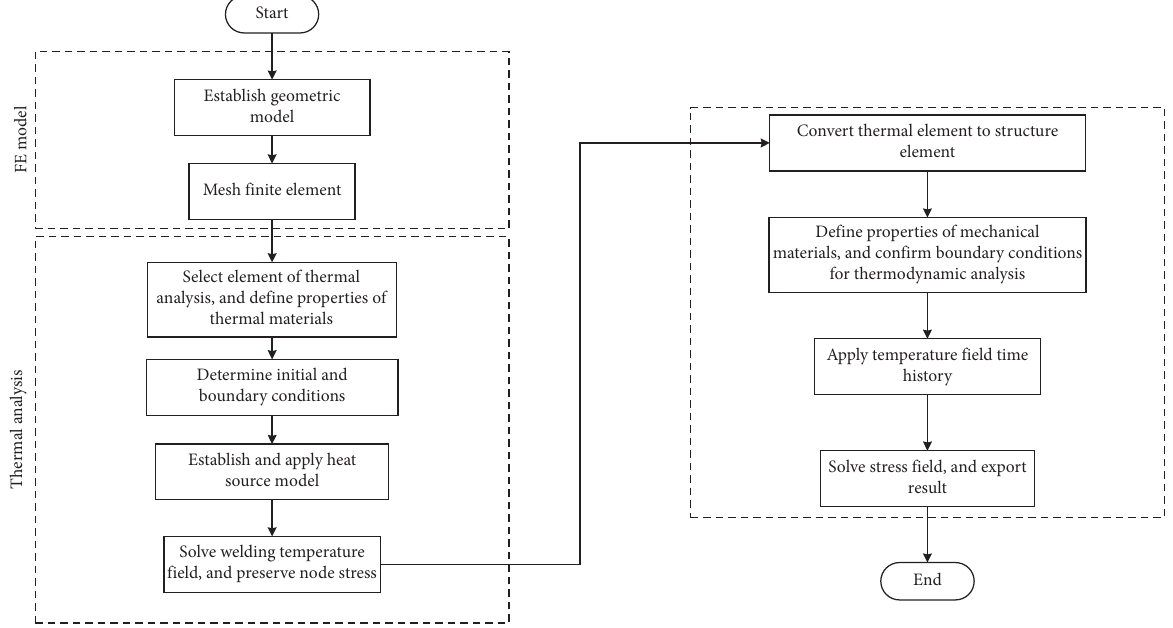
Figure 4: Flowchart of finite element analysis of welding process.